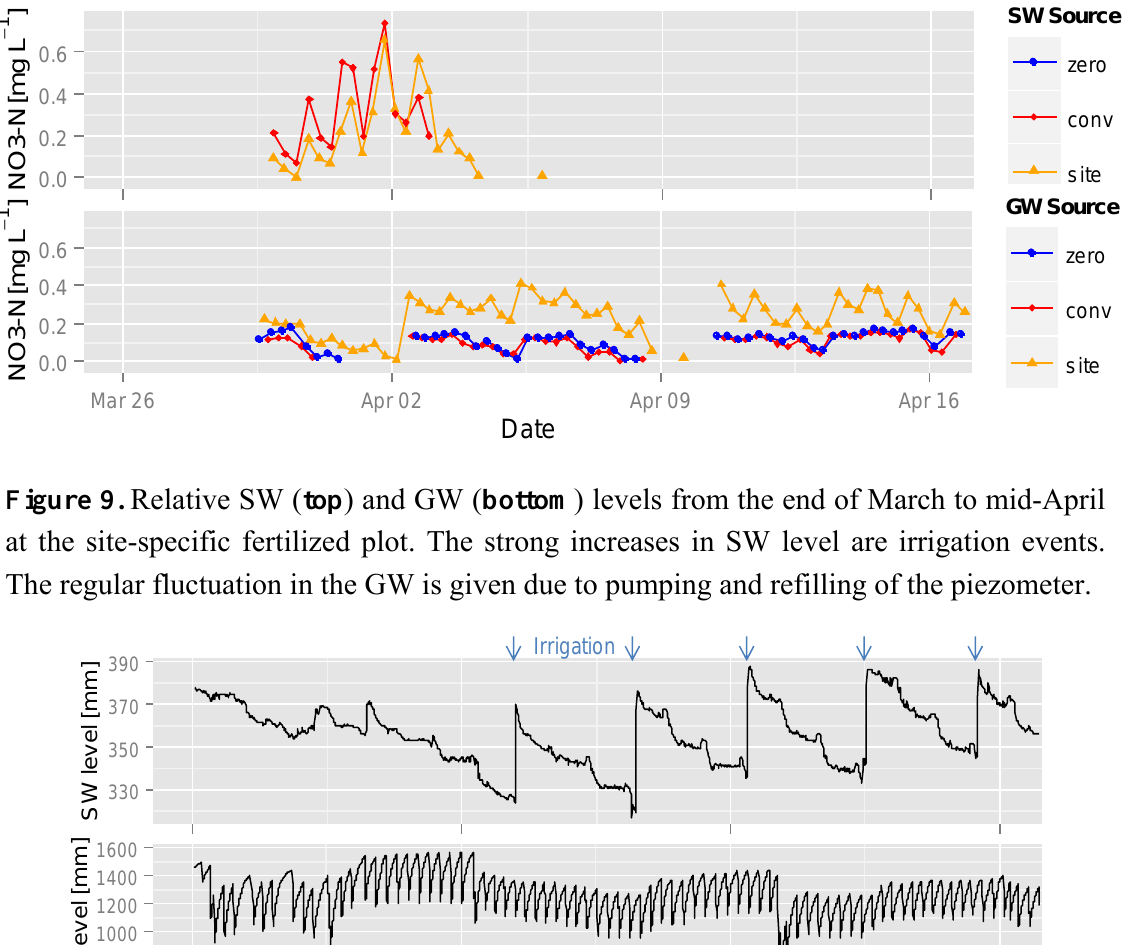
Figure 8. Nitrate concentration in SW ( top ) and GW ( bottom ) in different fertilized rice plots from 30 March to 17 April. Nitrate concentration in zero-fertilized SW was under the detection limit of the sensor.